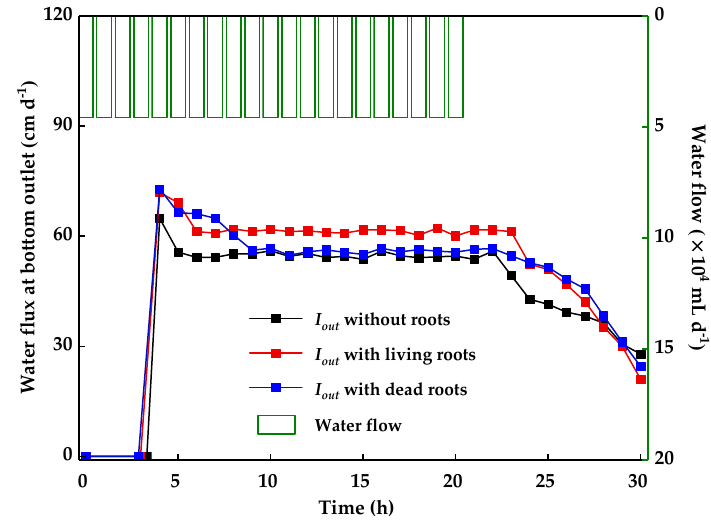
Figure 3. Water flux at the bottom of containers without or with living and dead roots.